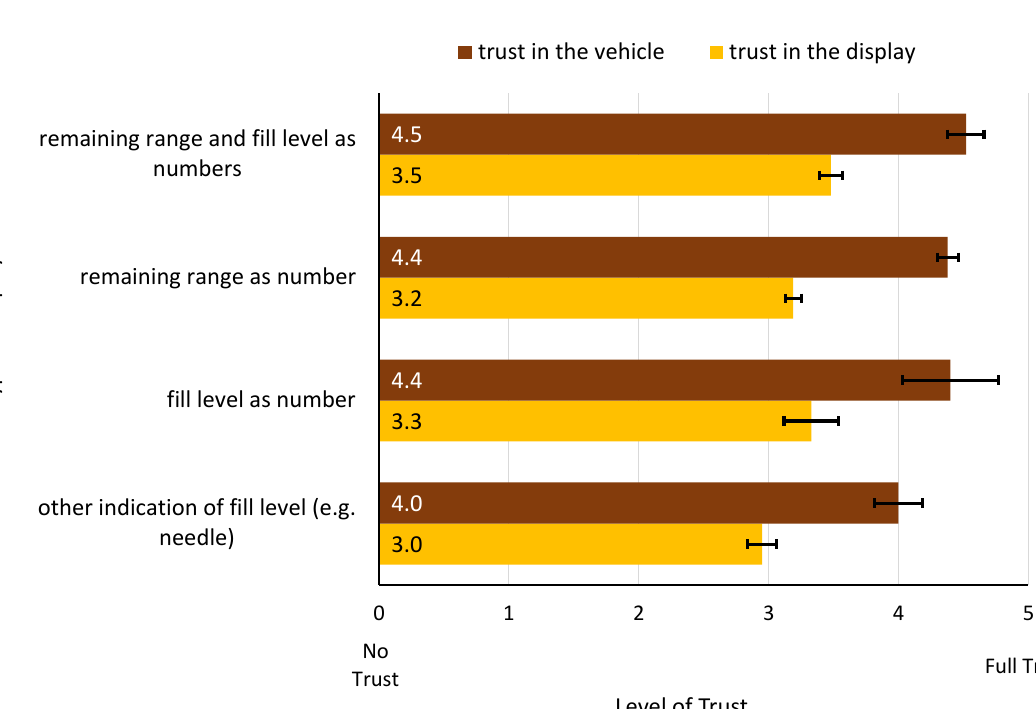
Figure 5. Perceived trust in the vehicle and in the tank or battery display independent of experience group (Means and related Standard Errors, scale min = 0, scale max =